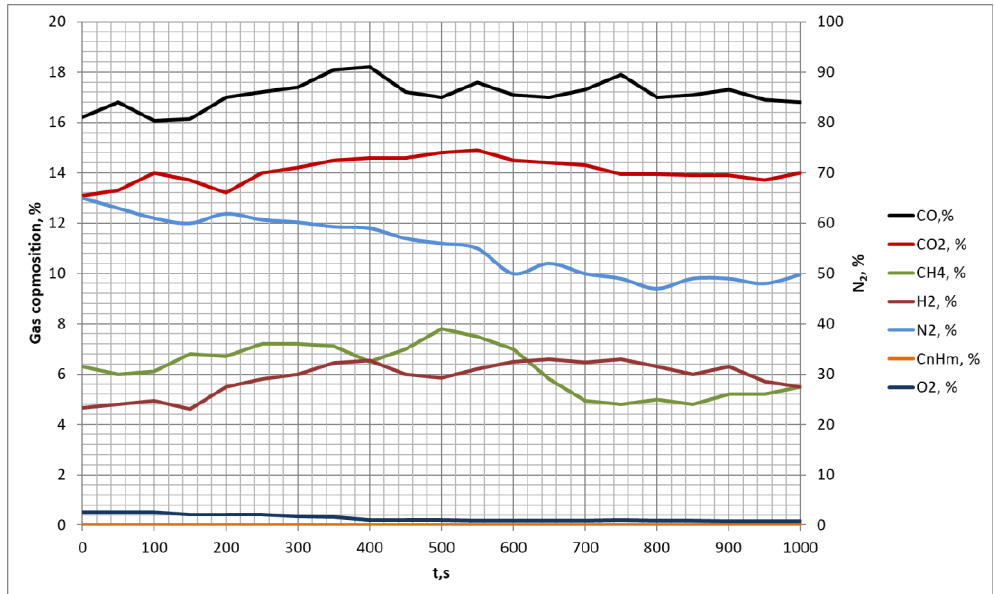
Figure 5. Results of the measurements of the process gas composition.